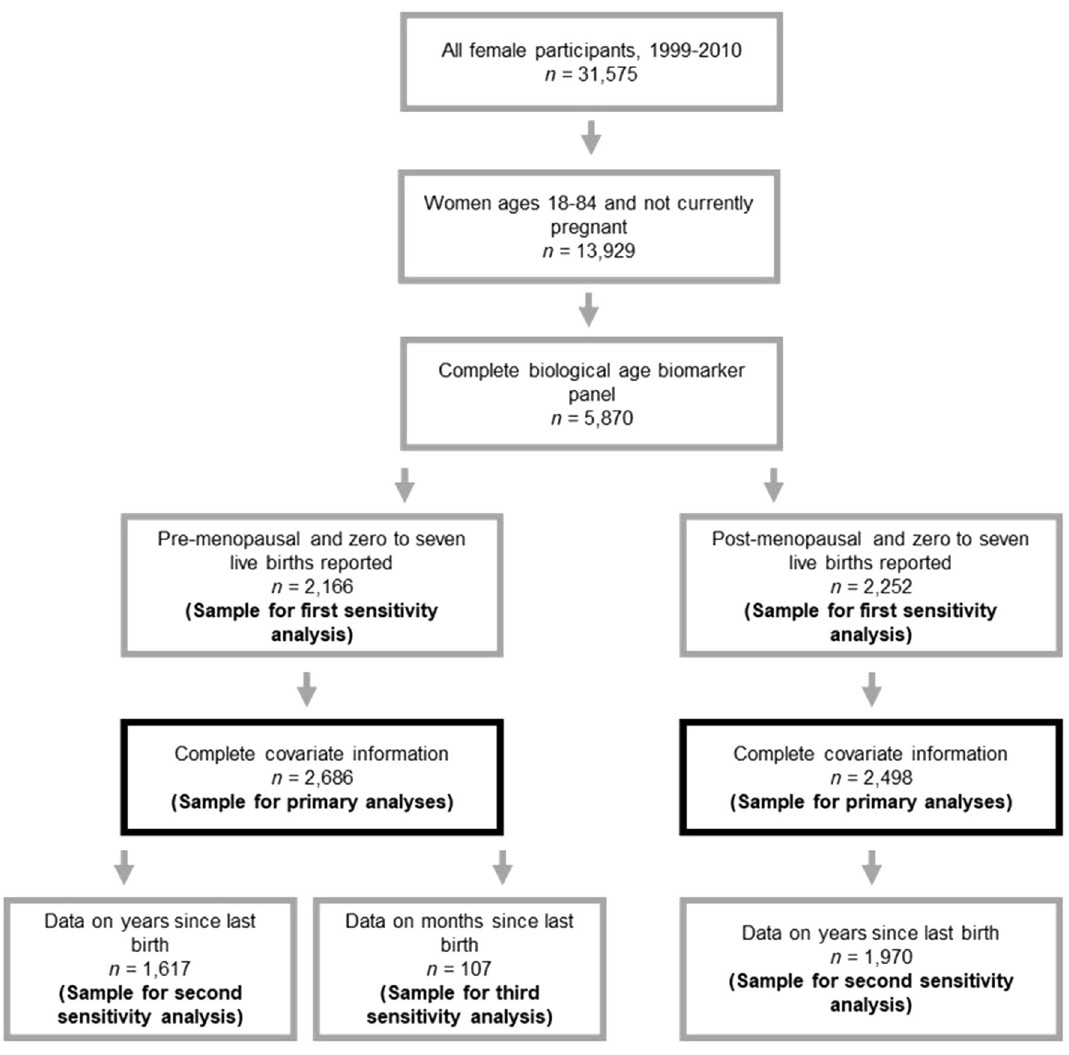
Figure 1. Flow chart illustrating sample